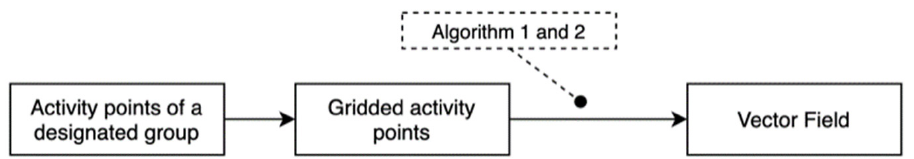
Figure 10. The process of constructing a travel-demand vector field.